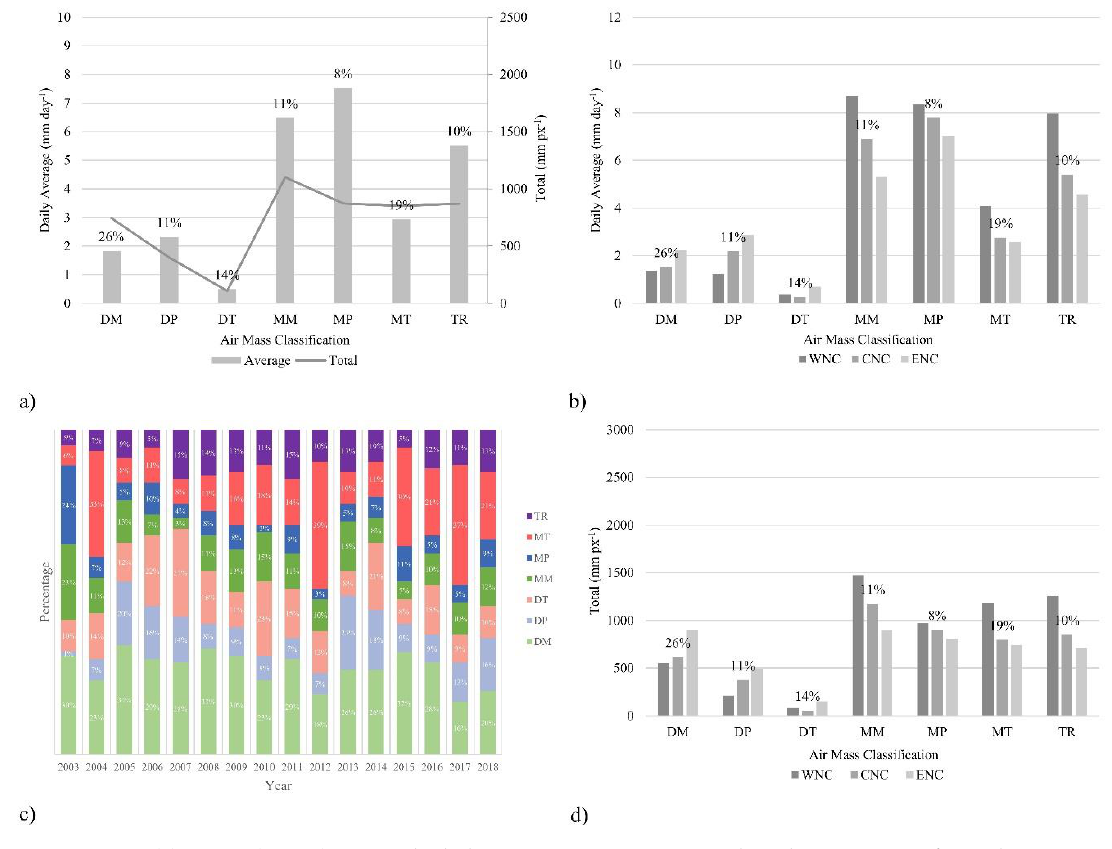
Figure 6. ( a ) spring (MAM) statewide daily average precipitation and total precipitation for each SSC Figure 6. Same as Figure 4 but for spring (MAM). air mass classification; ( b ) daily average precipitation for each North Carolina region; ( c ) frequency of each SSC air mass classification over the study period; ( d ) total precipitation for each North Carolina region. Percentages indicate the fraction of air mass classification for each season ( a , b , d ) or year ( c ). Totals are presented as millimeters per pixel (mm px − 1 ), which is equivalent to millimeters per grid